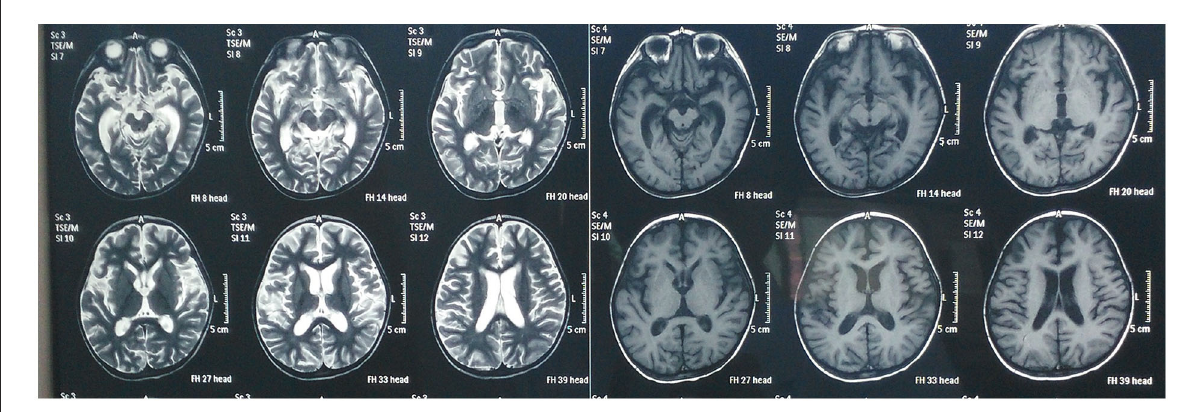
FIGURE1 Magnetic resonance imaging of the brain before receiving Tongdu Xingshen acupuncture showed mild brain atrophy and pachymeningeal enhancement associated to